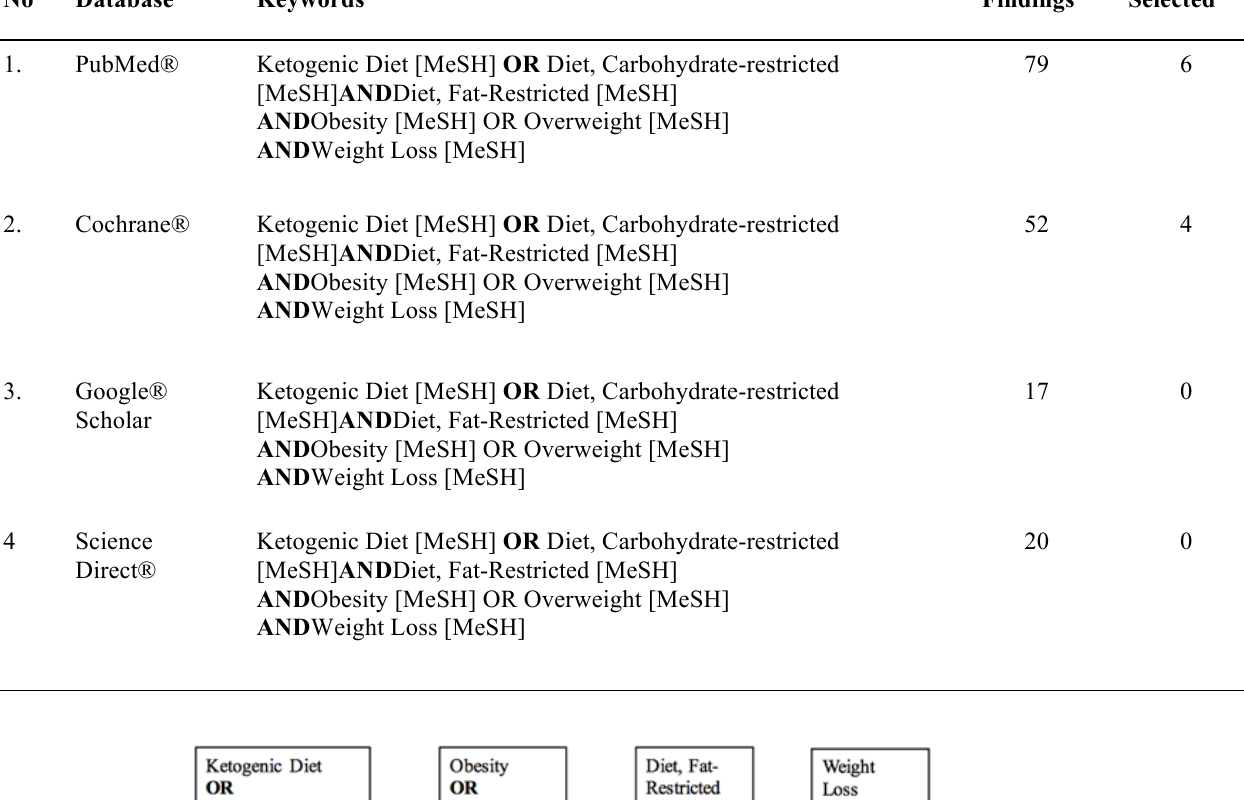
Table 2. The strategies for article search No